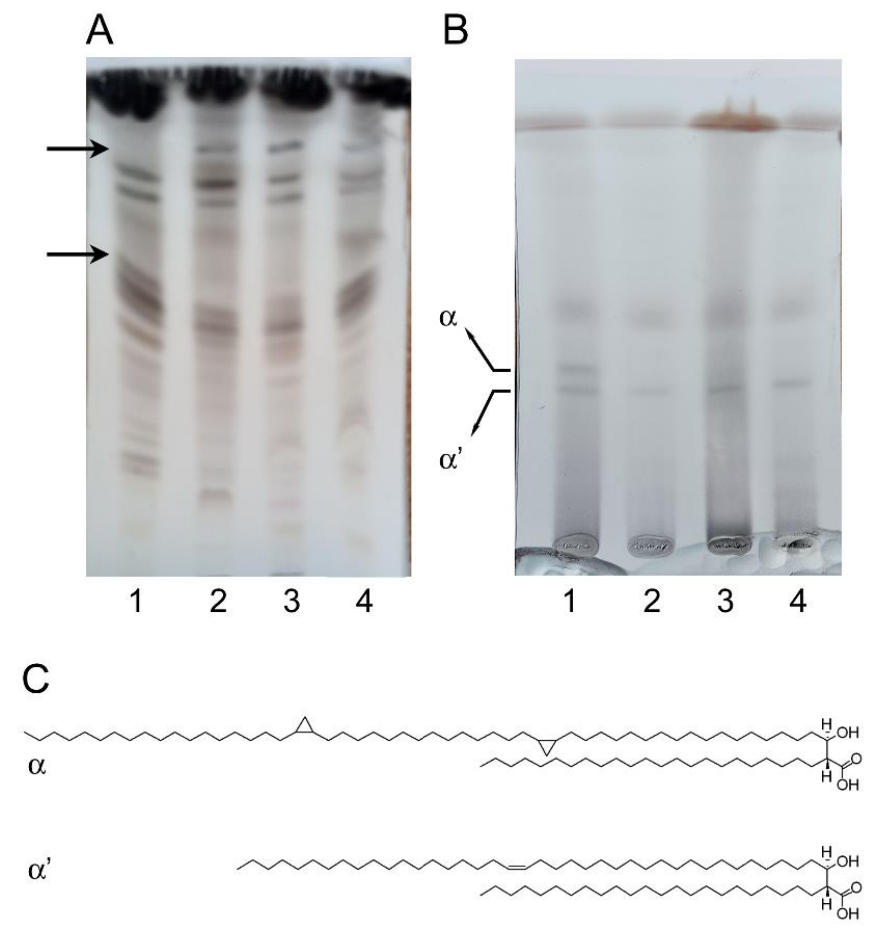
Figure 5. Effects of the compounds on Mab cell wall composition. Mab cells were grown for 48 h in the absence/presence of compounds, and the lipid composition was then analyzed as in Material and Methods. ( A ) TLC analysis of the complete lipid profile extracted and separated in solvent CHCl 3 /CH 3 OH/H 2 O (20:4:0.5). ( B ) total mycolic acid methyl esters (MAMEs) and fatty acid methyl esters (FAME) extracted from delipidated cell pellets were separated in hexane/ethyl acetate (95:5). α and α ’-mycolic acids correspond to long-chain (C77–79) and short-chain (C62–64) mycolic acids